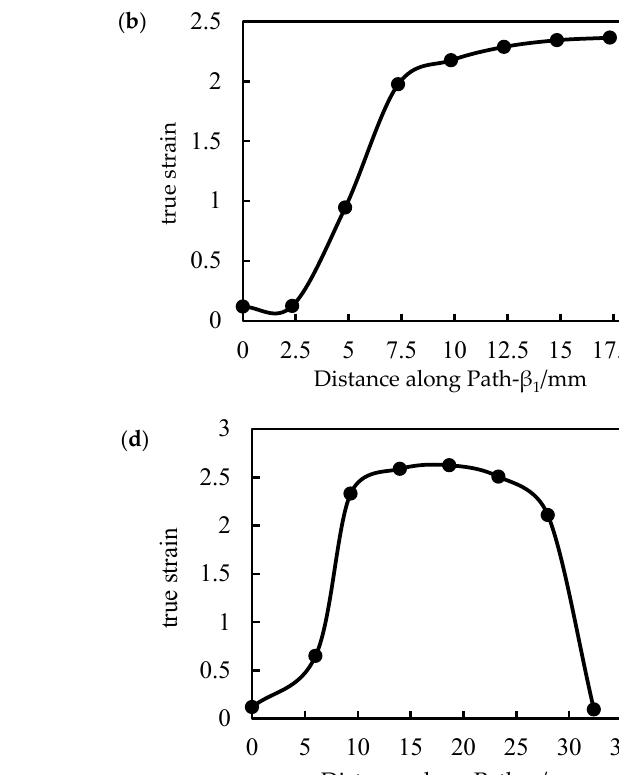
19 of 21 Figure 21. Distribution of stress of ribs along each path. ( a ) Path- α , ( b ) Path- β 1, ( c ) Path- β 2, ( d ) Path- γ .